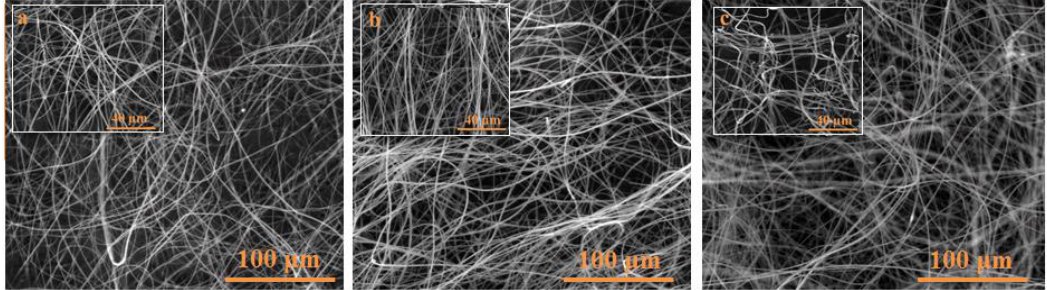
Figure 4. SEM micrographs of the electrospun polyimide fibers ( a ), electrospun polyimide fibers exposed to PBS (Phosphate-Buffered Saline) for two days ( b ) and six days ( c ) at 100 μm magnification and 40 μm, respectively.